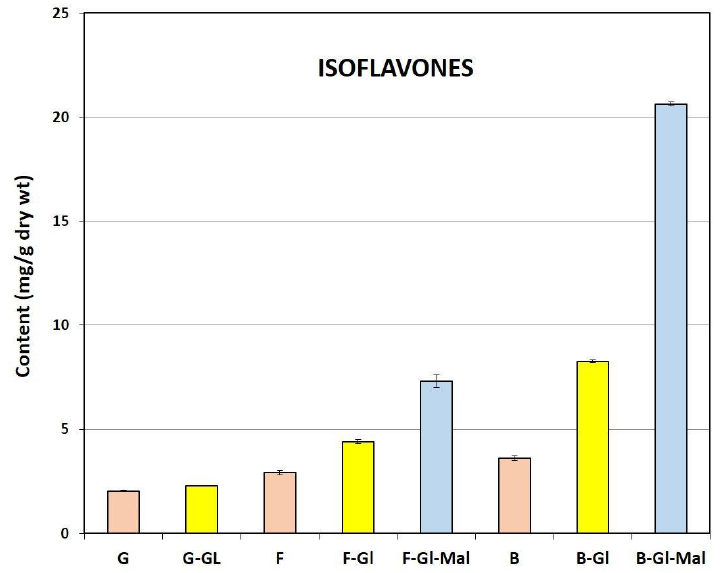
Figure 3. The mean ( n = 9) content (mg/g dry wt) of isoflavones determined in TML. Compound name abbreviations as in Figure 2. The colors of each graph refer to the three isoflavone groups shown in Figure 4.